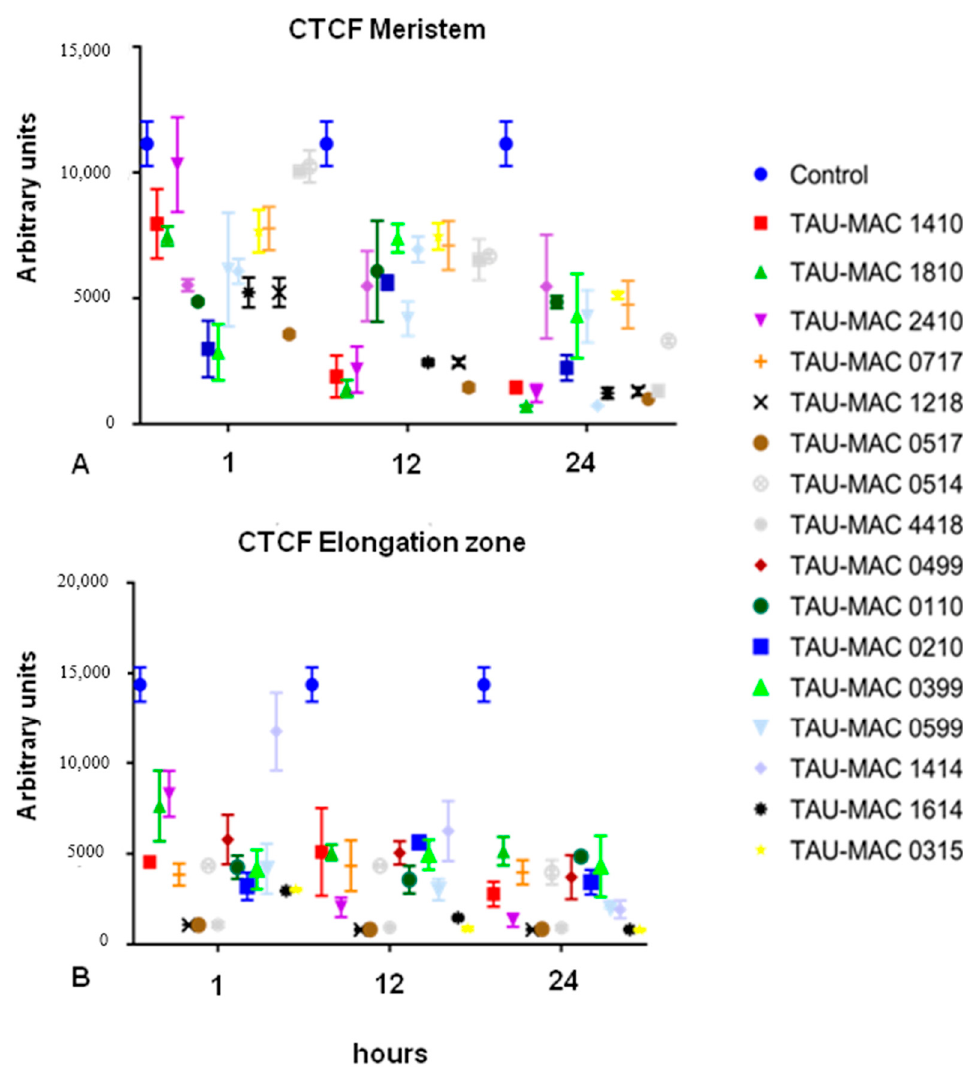
Figure 10. Graphs illustrating the corrected total cell fluorescence (CTCF) intensity measurements of untreated (control) and extract-treated root meristem ( A ) and elongation zone cells ( B ). Note that fluorescence intensity drops significantly even upon 1 h of treatment, especially in the elongating root